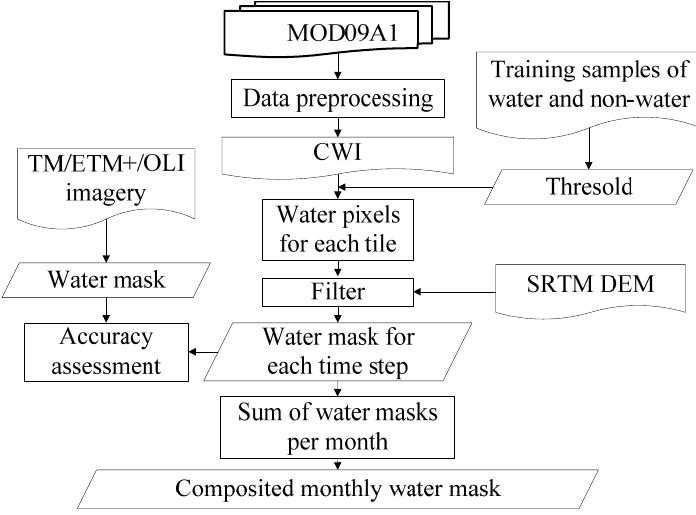
Figure 2. Workflow for water body extraction in our